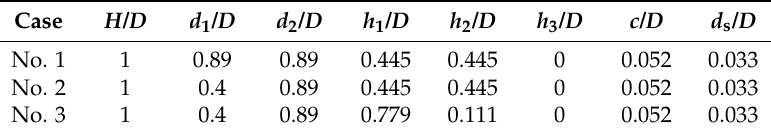
Table 2. Geometrical parameters of mixing systems with a dished bottom vessel.